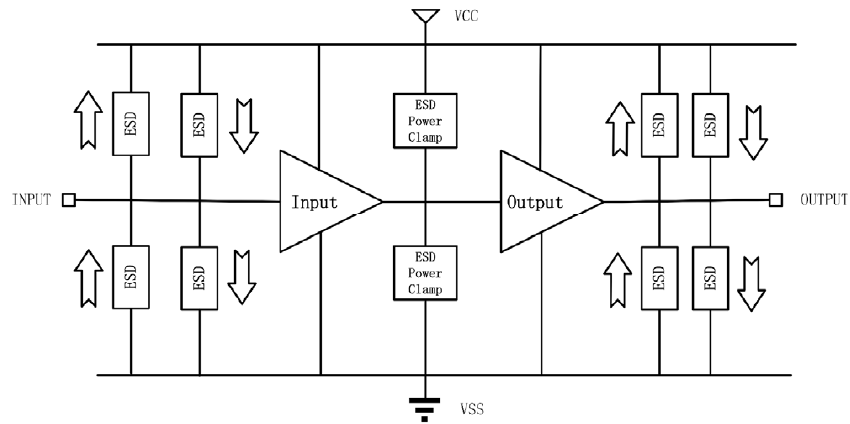
Figure 1. Illustration for a full-chip ESD protection scheme.